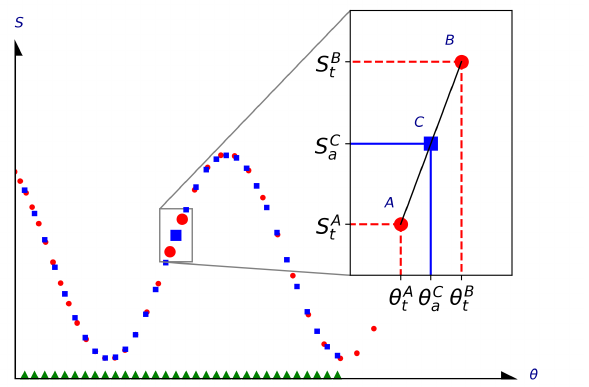
Figure 2. Example of Angular